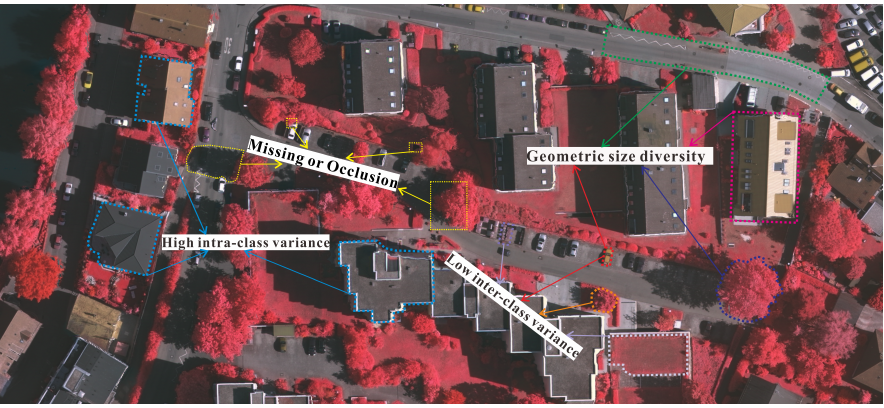
Figure 1. Challenges of object segmentation in spatial distribution in remote sensing